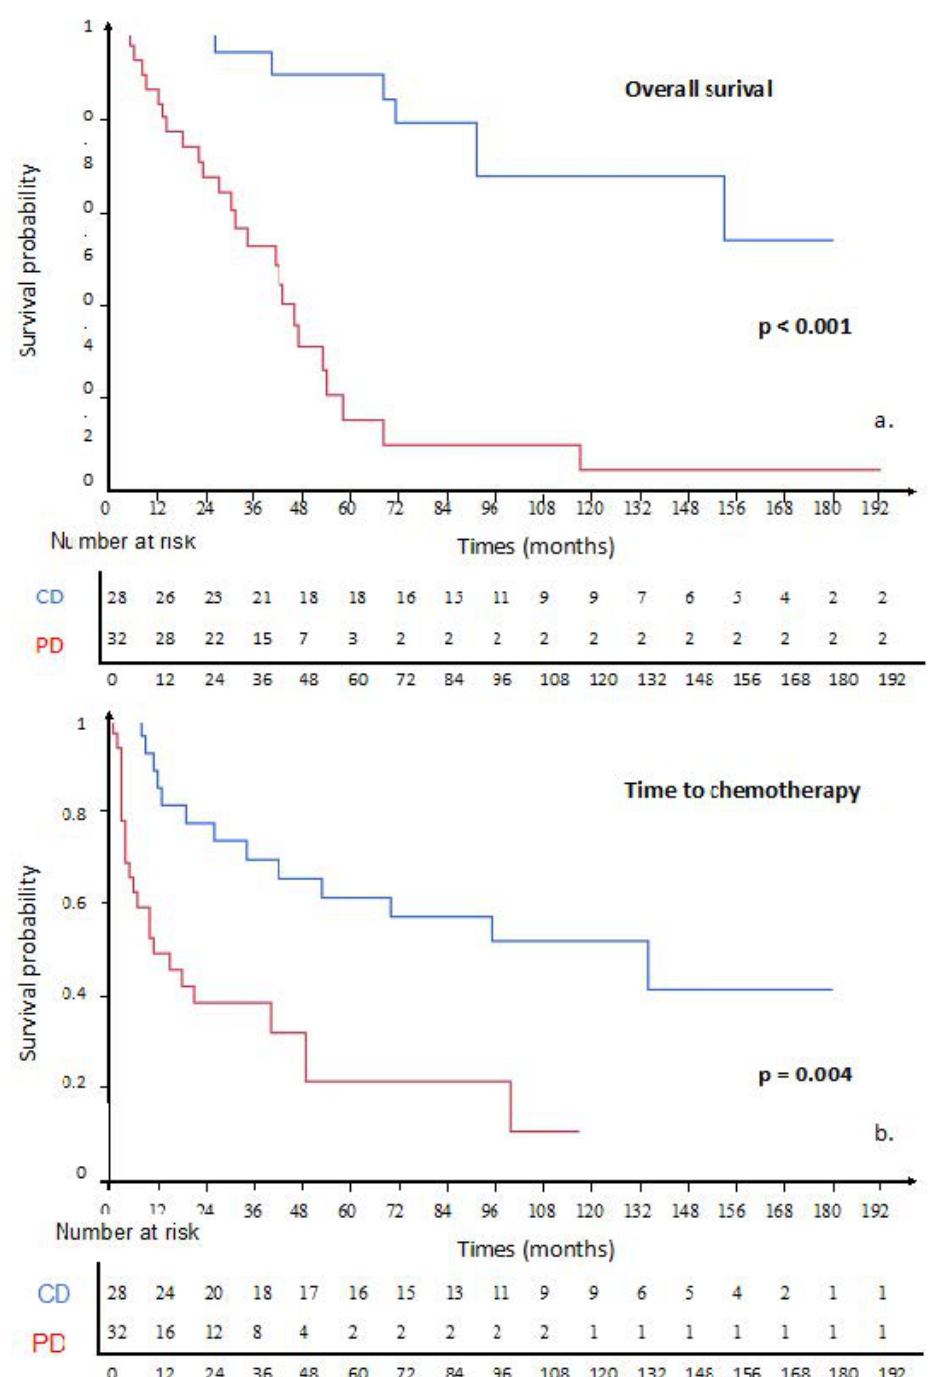
Figure 2. Kaplan-Meir estimate since mitotane initiation in DC patients and PD patient for ( a ). Overall survival; ( b ). Time to chemotherapy. (DC: controlled disease; PD: progressive disease.). The characteristics of patients with DC are detailed in Table 3. The following fac- Table 3. Characteristics of patients with disease control (best response during follow-up). p = 0.002), Dmax < 3 cm (HR: 3.78 (95% CI: 1.09–13.14), p = 0.035). Both factors Parameters Patients with PD Patients with CD p Patients n = 20 n = 40 Age at stade IV diagnosis (year, IQR)